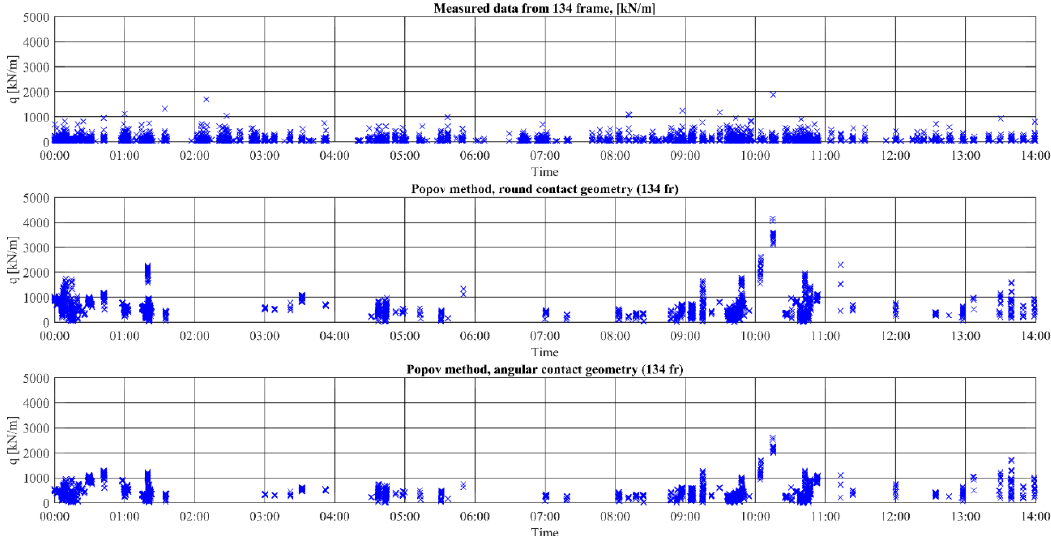
Figure 5. Excerpt of the measured and calculated line ice loads for data set A.